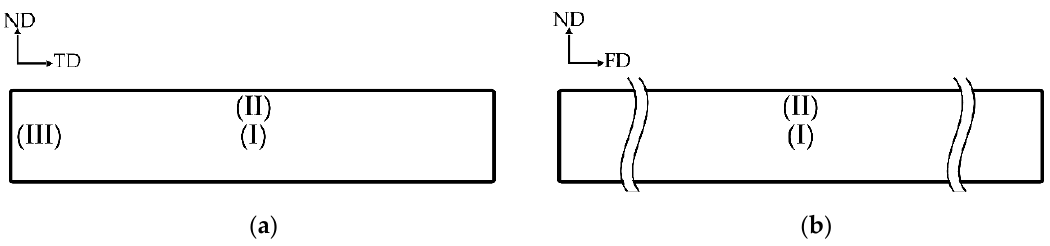
Figure 7. Observed SEM morphology location of sheet sample: ( a ) transverse direction (TD) and ( b ) flow direction (FD).